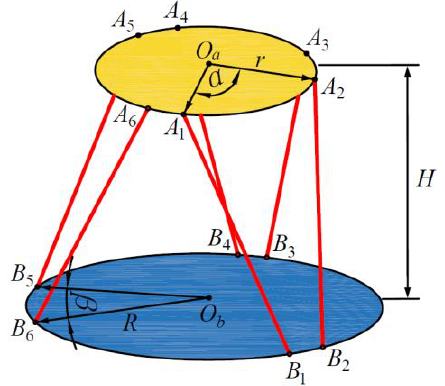
Figure 2. Structure of the 6-UPS parallel mechanism.